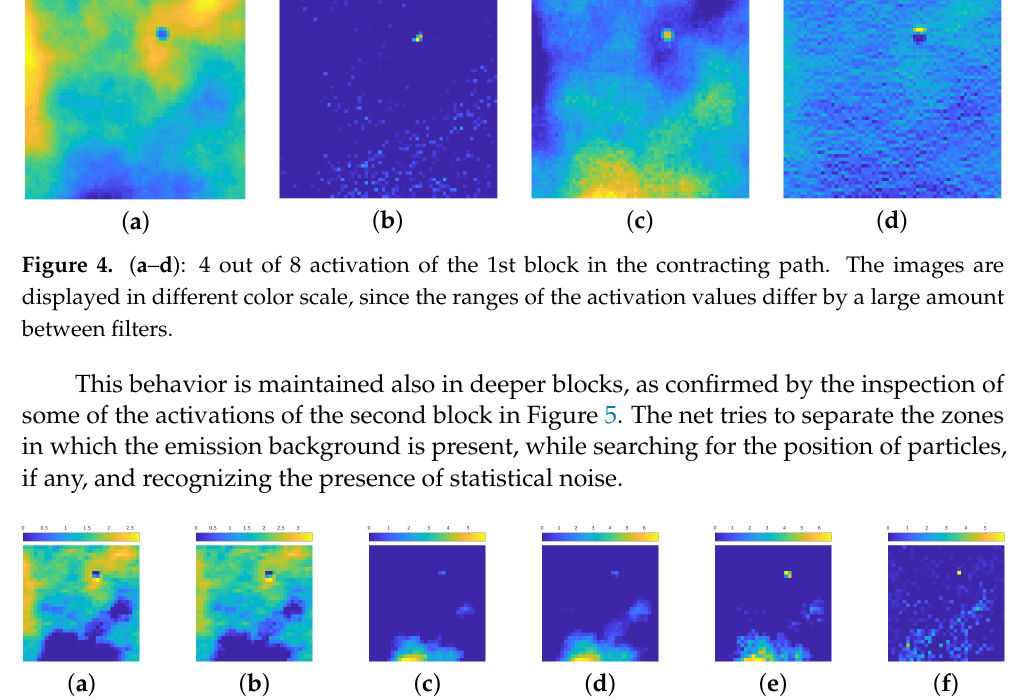
Figure 5. ( a – f ): 6 out of 16 activation of the 2nd block in the contracting path. The color scale is not the same among the images, due to different value ranges among the